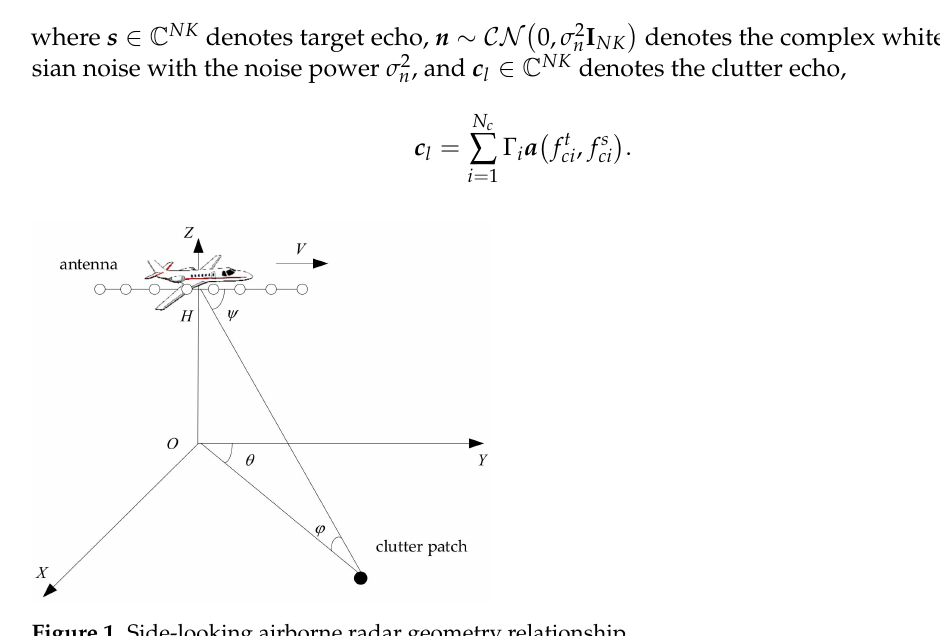
Figure 1. Side-looking airborne radar geometry